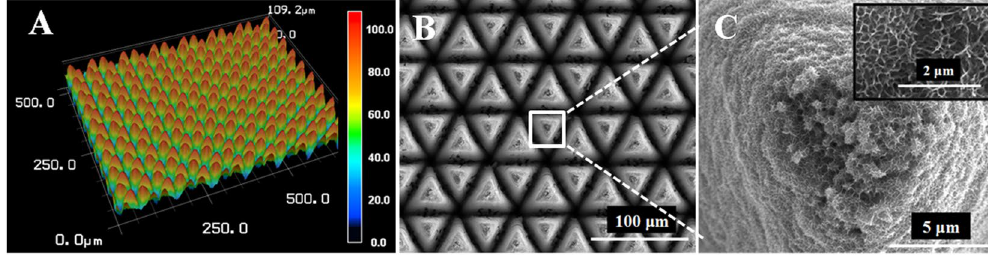
Figure 3. ( A ) LSCM image, ( B ) and ( C ) FESEM top-view images at different magnifications of the final